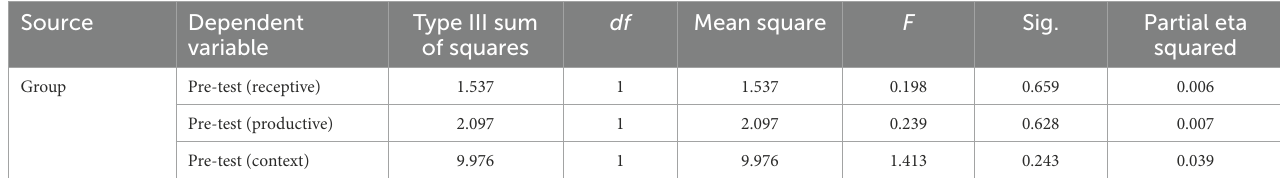
TABLE 2 Tests of between-subjects effects for the scores on pre-tests. Source